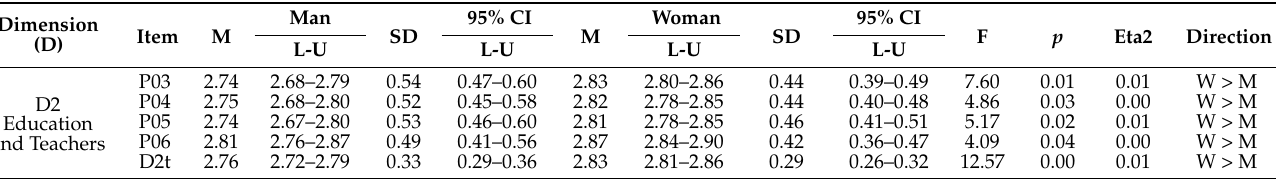
Table 4. ANOVA for Sex-independent samples for dimension